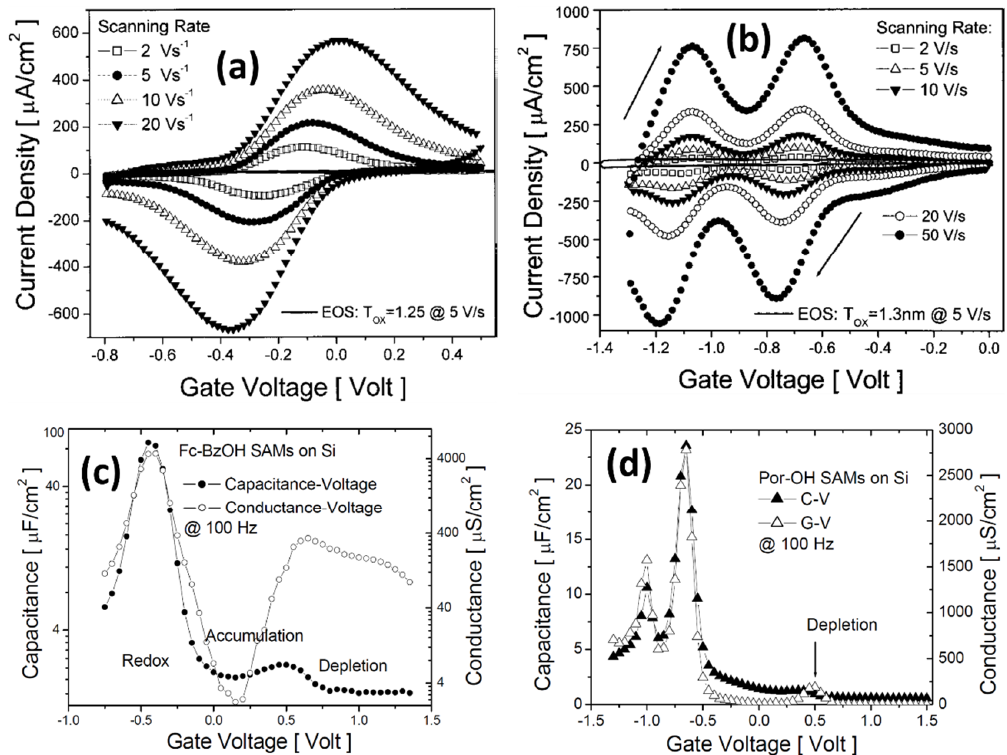
Figure 5. Cyclic voltammetry of electrolyte-molecule-oxide-Si (EMOS) structures with ( a ) the Fc-BzOH and ( b ) the Por-BzOH redox molecule attached to SiO 2 at different voltage scan rates; capacitance-voltage (C-V) and conductance-voltage (G-V) curves of ( c ) Fc-BzOH and ( d ) Por-BzOH EMOS capacitors at 100 Hz. Reproduced with permission from [35,37], © AIP Publishing LLC, 2003, 2004.